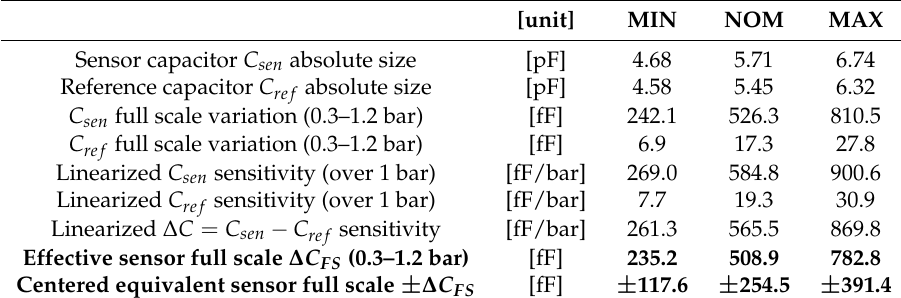
Table 1. Given pressure sensor MEMS sensitivity estimations.